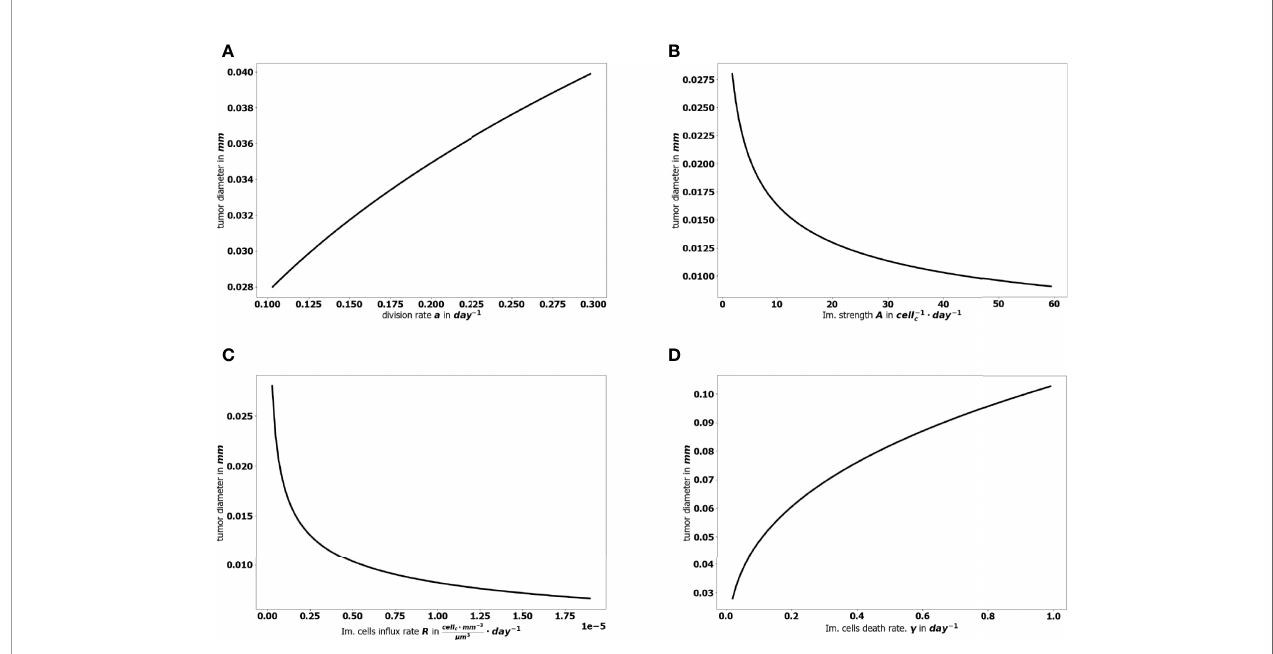
FIGURE 6 | Evolution of the tumor diameter at equilibrium, with respect to (A) the division rate of tumor cells a , (B) the strength of the effector immune cells A , (C) the in fl ux rate of effector immune cells R , (D) the natural death rate g of the effector cells.